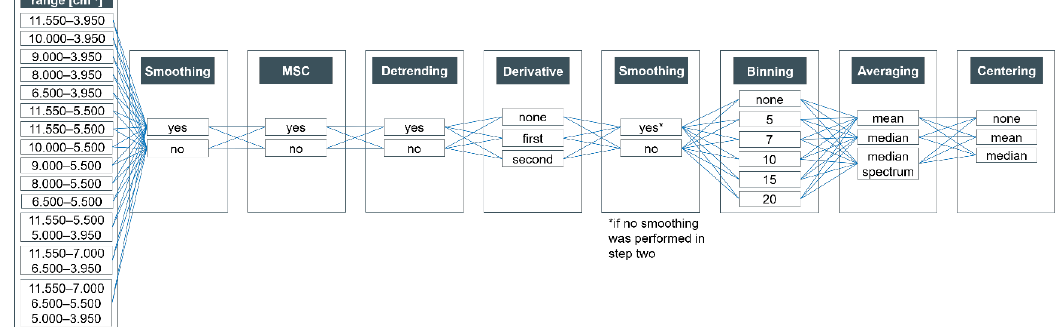
Figure 1. Flowchart showing all different combinations of pre-processing methods applied in the optimization. In total, all combinations lead to 50,545 different pre-processing strategies. Smoothing was performed either in second or sixth place, double smoothing in one pre-processing combination has not been performed; MSC — multiplicative scatter correction.